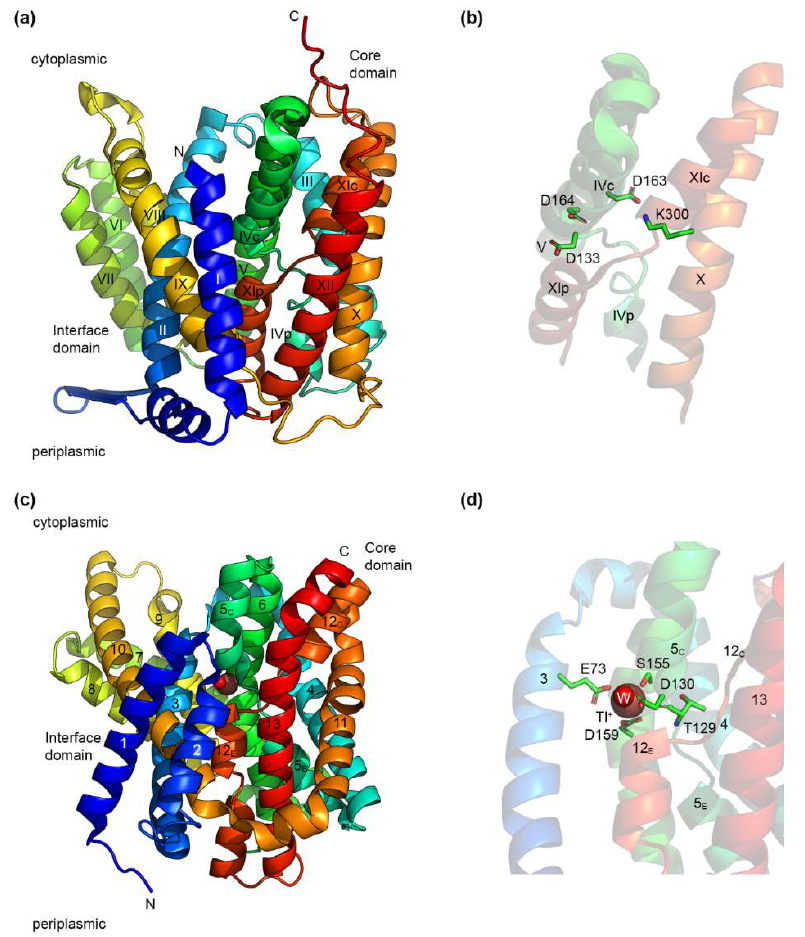
Figure 1. Structures of EcNhaA and PaNhaP. ( a ) Crystal structure of EcNhaA (PDB accession number: 4ATV) obtained at low pH in the inward-open conformation. TMHs are labeled according to the original structure publication [24]. ( b ) A detailed look at the structure in panel ( a ) showing the crossed interrupted helices of EcNhaA and its putative substrate binding region. Three aspartate residues are present in this region, out of which, Asp163 forms a salt bridge with Lys300. ( c ) The crystal structure of PaNhaP (PDB accession number: 4CZA) obtained at high pH in the inward-open conformation. A Tl + ion (also a substrate of PaNhaP) and a water molecule are present in the substrate binding site. TMHs are labeled according to the original structure publication [27]. ( d ) A detailed look at the structure in panel ( c ), showing the substrate binding site of PaNhaP and the residues coordinating the Tl + ion. Structures were drawn using the PyMOL Molecular Graphics System, Version